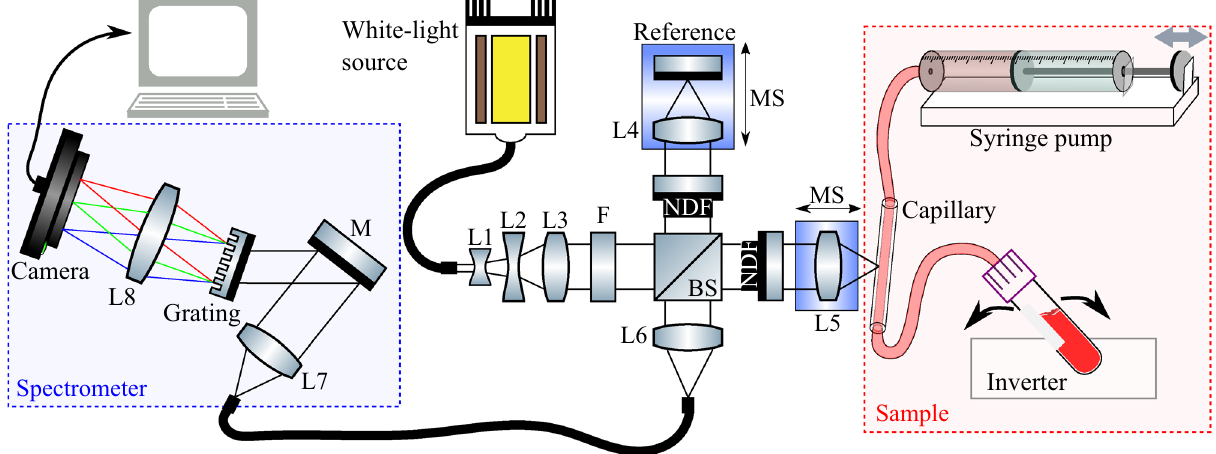
Figure 1. Schematic of the sOCT system to measure ex-vivo [tHb] in flowing whole human-blood. Light propagated through the optical system and focused into the capillary tube. A syringe pump established blood flow from a falcon tube placed on an inverter. Light backscattered by blood and reflected at the reference mirror was collected and guided to the spectrometer. L1–L8 lenses; F short-pass filter; BS beamsplitter; NDF neutral density filter; MS motorised stage; M